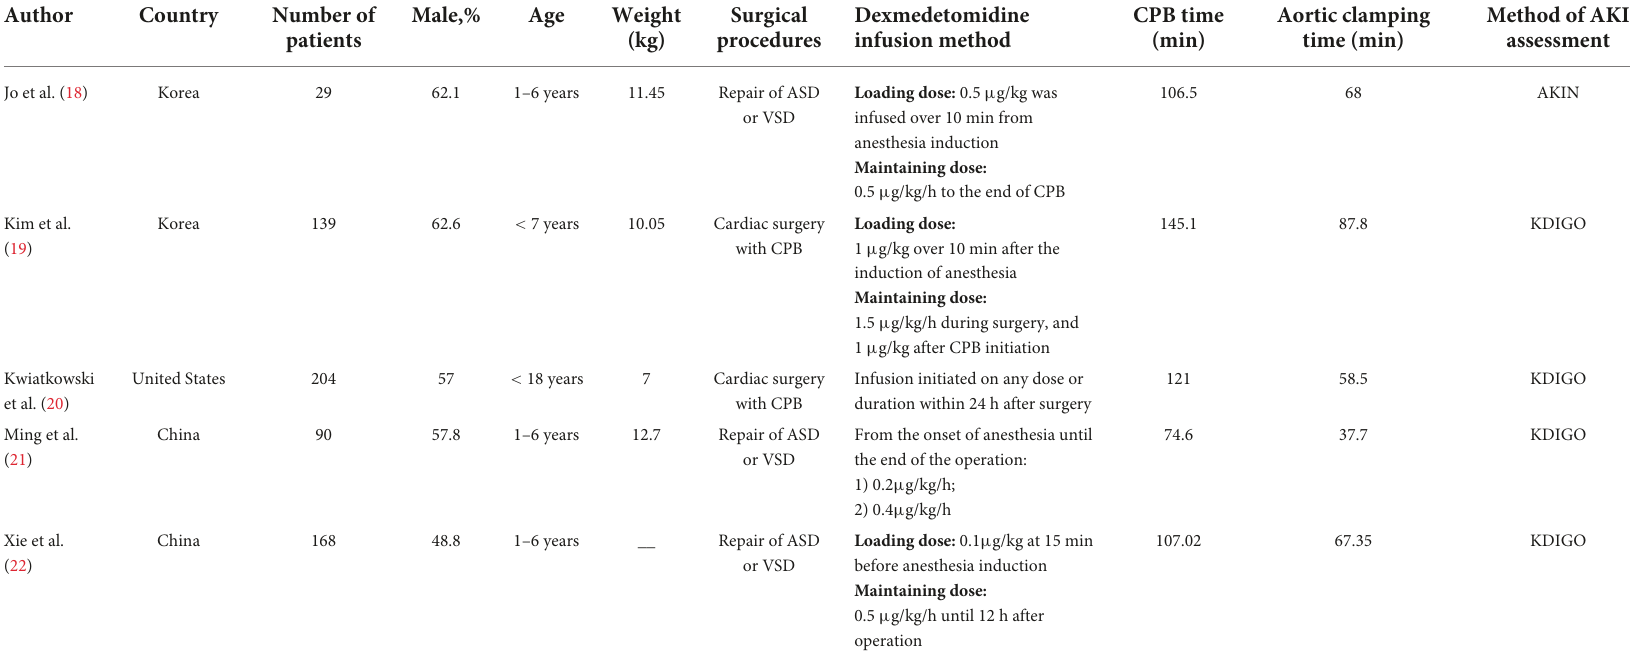
TABLE 1 Basic characteristics of included